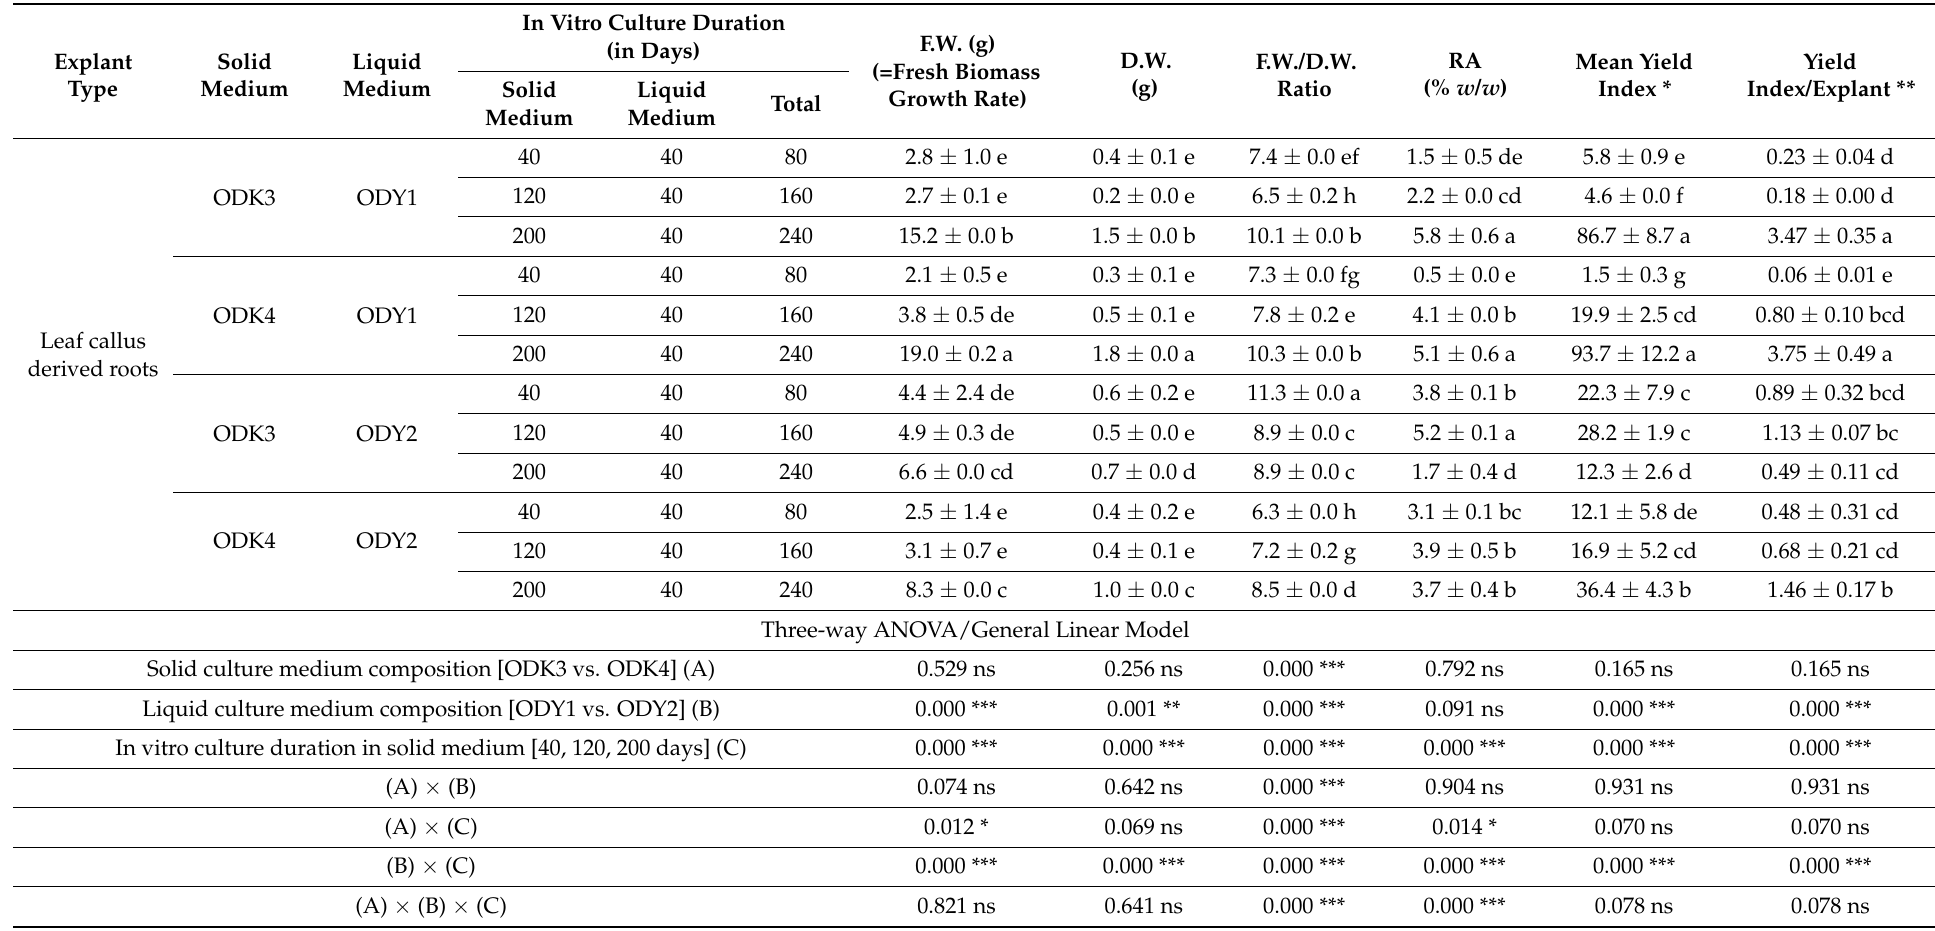
Table 1. Effect of media composition and combinations, and three incubation periods on biomass growth (FW, DW, FW/DW ratio), and RA production expressed